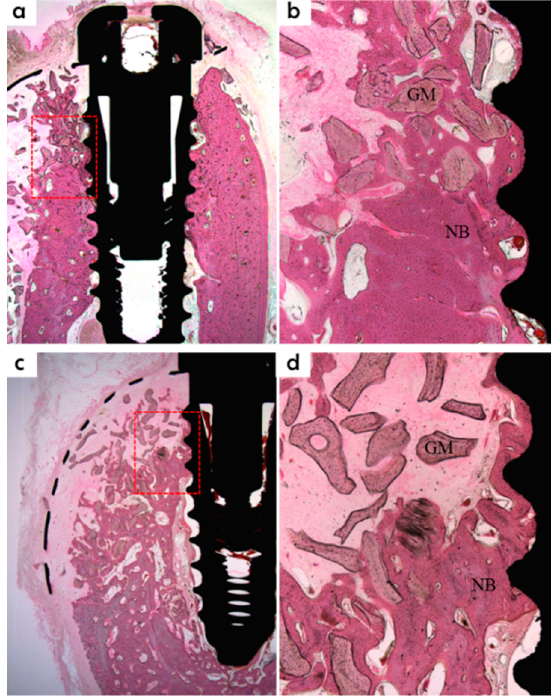
Figure 13. Histological sections of the titanium group at week 8 after surgery. A significant amount of new bone formation was observed. GM, bone grafting material; NB, new bone. (H&E stain; original magnification 12.5× ( a ) and ( c ); 40× ( b ) and ( d )). Red box in ( a ) is the area of ( b ), red box in ( c ) is the area of ( d ).